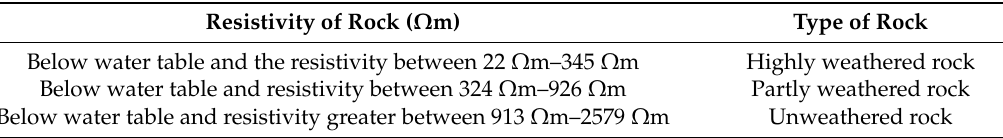
Table 1. Resistivity and lithology calibration in the study